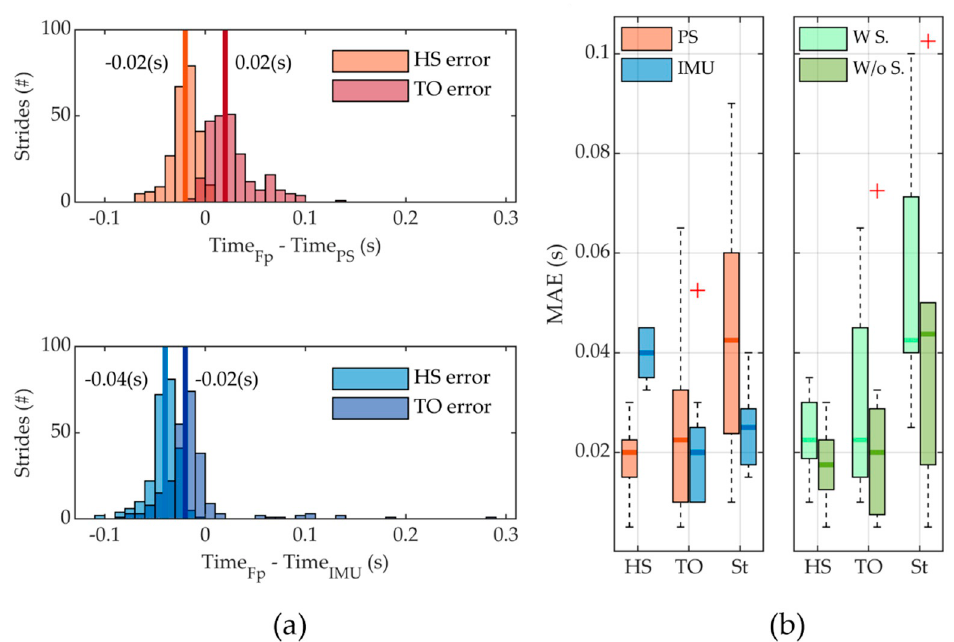
Figure 7. ( a ) Distribution of all time differences of all the strides analyzed, comparing the estimation between the PS (both in W S. and W/o S. conditions) and IMU-based algorithm for the force platform (FP), where a positive time difference means early detection of the event, while a negative time difference is representative of late detection of the event, and median values are in bold; ( b ) boxplots of the median absolute errors (MAE) in the detection of HS, TO, and the stance duration using PS (both in W S. and W/o S. conditions) and IMU, where outliers are reported as red marks. Additionally, MAE distribution is shown for PS separately for the two conditions (W S.–W/o